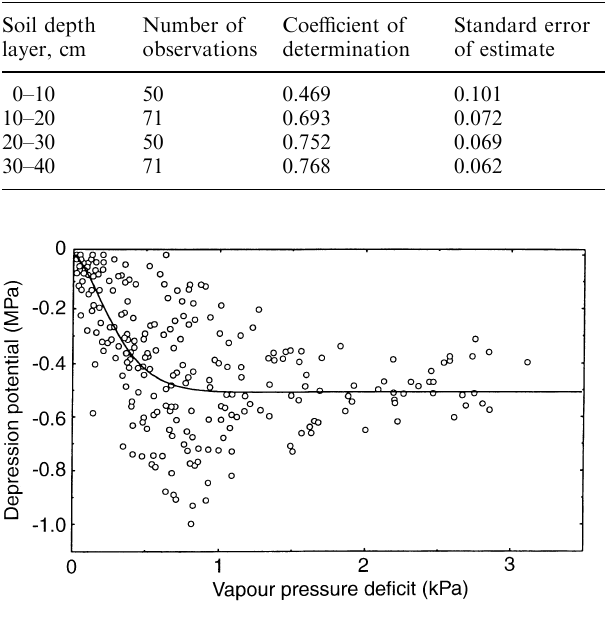
Fig. 2. The depression potential (cid:133) (cid:87) d (cid:134) of shoots versus current vapour pressure deficit of the